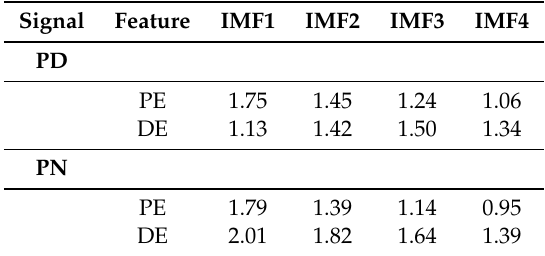
Table 1. PE and Dispersion Entropy (DE) values for each IMF of the example PD and PN signals.